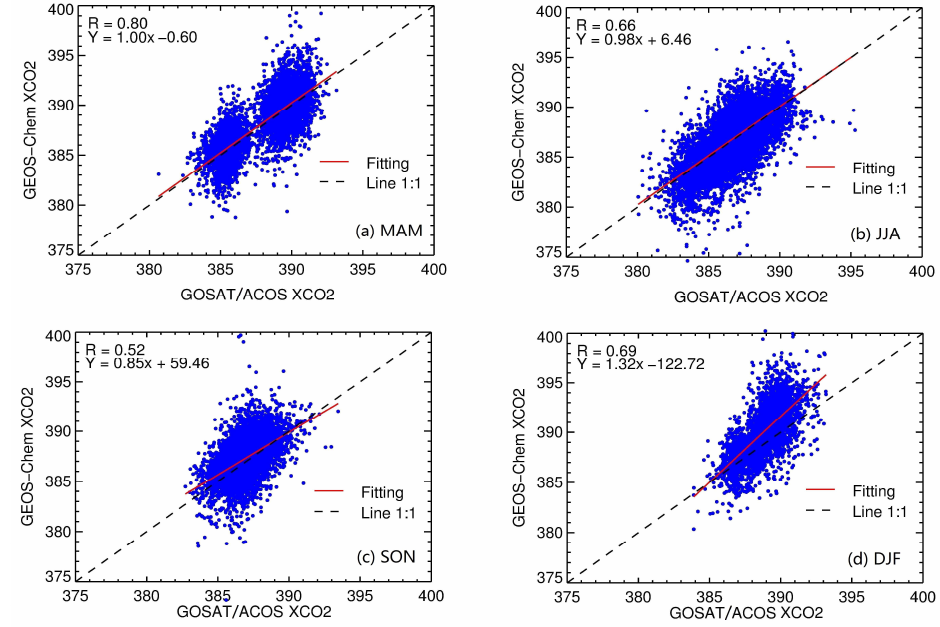
Figure 3. Scatter plots of XCO 2 retrievals of GOSAT/ACOS v7.3 versus XCO 2 simulation from GEOS-Chem during March 2010–February 2011. ( a )–( d ) indicate MAM, JJA, SON and DJF respectively. Unit: ppm.